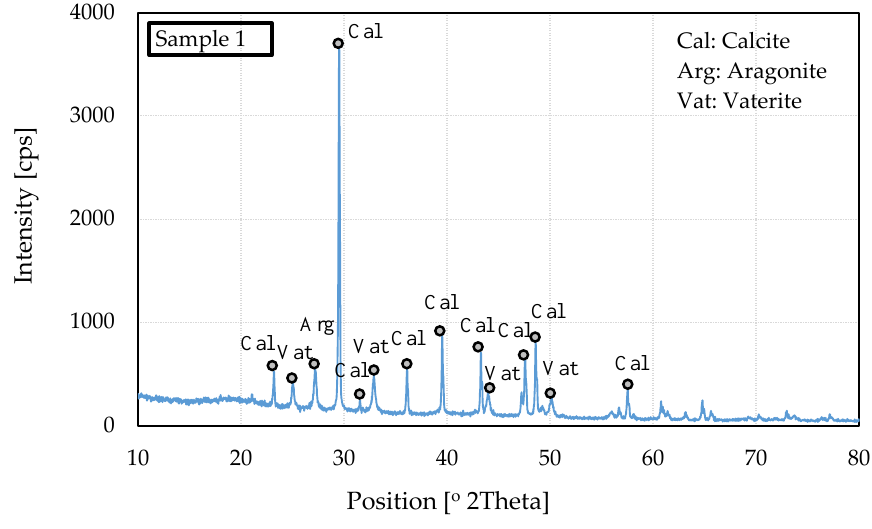
Figure 9. XRD pattern for sample 1 specimen.